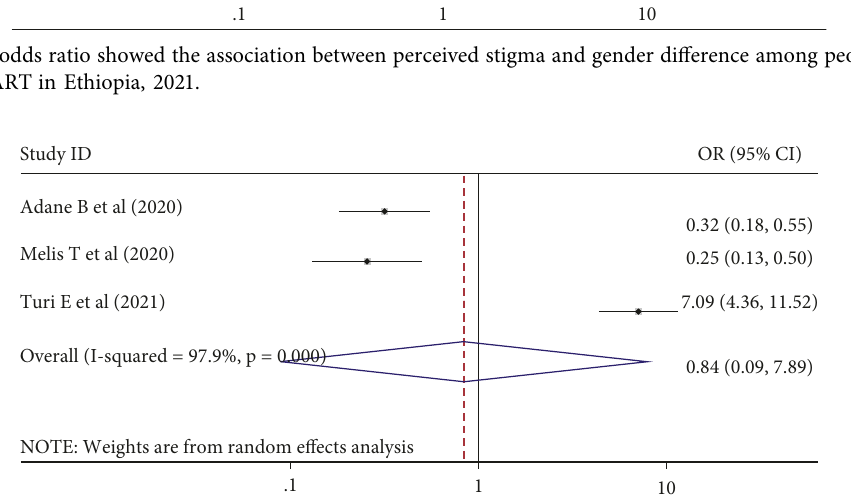
Figure 5: The pooled odds ratio showed the association between perceived stigma and disclosure status among people living with HIV/ AIDS and attending ART in Ethiopia, 2021.